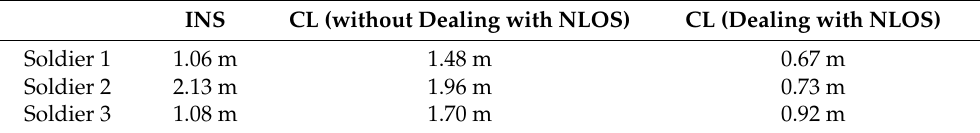
Table 2. Positioning RMSE of soldiers using different methods in building environment experiment. INS CL (without Dealing with NLOS) CL (Dealing with NLOS) Soldier 1 1.06 m 1.48 m 0.67 m Soldier 2 Soldier